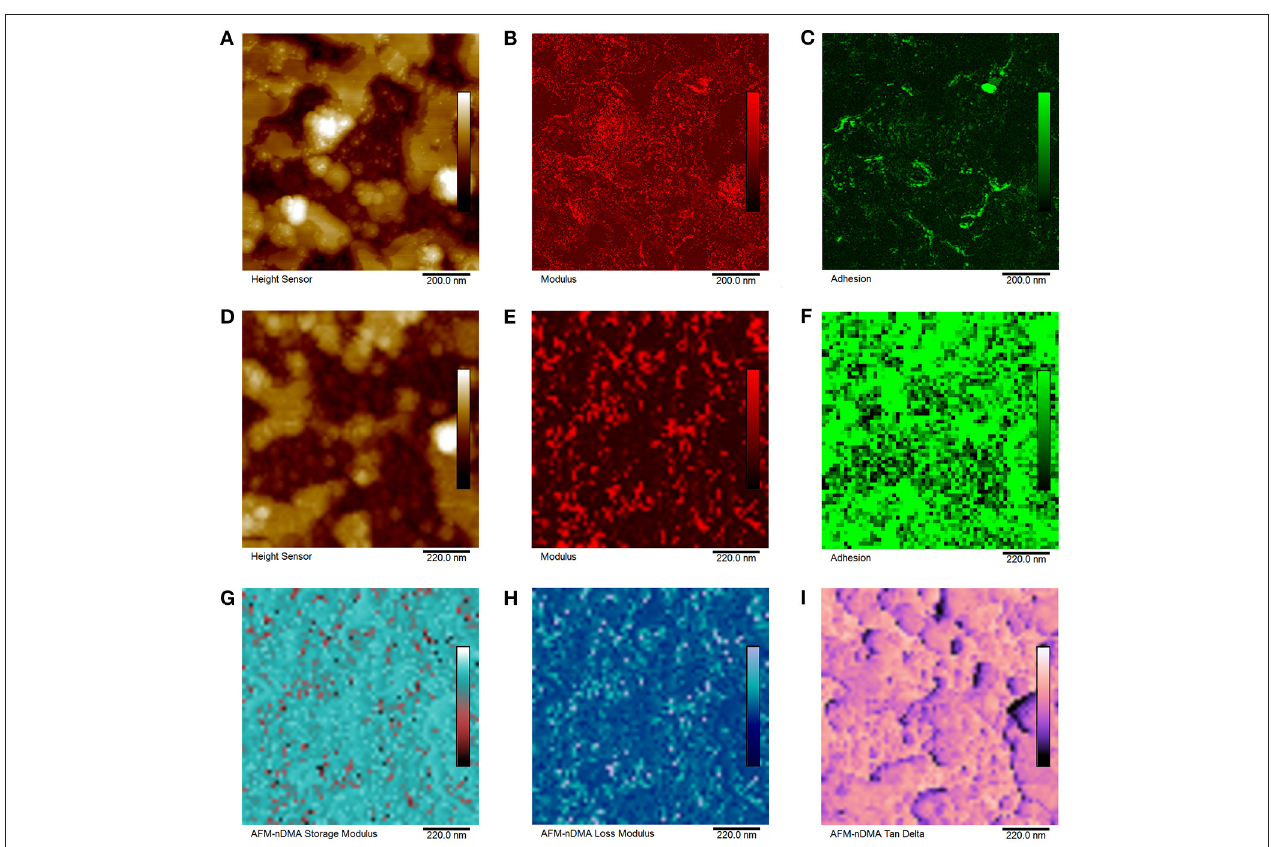
FIGURE 2 | Nanomechanical mapping of rSfp1 Beta C-term coating prepared in artificial sea water and observed in deionized water using (A,C) Peak Force QNM mode, (D–I) nDMA mode in fluid. (A) Height, scale: 50 nm, (B) Modulus, scale: 10 MPa, (C) Adhesion, scale: 500 pN, (D) Height in nDMA mode, scale: 50 nm, (E) Modulus, scale: 10 MPa, (F) Adhesion, scale: 500 pN, (G) Storage modulus, scale: 17.5 MPa, (H) Loss modulus, scale: 15 MPa, and (I) Tan Delta, scale: 0.400.